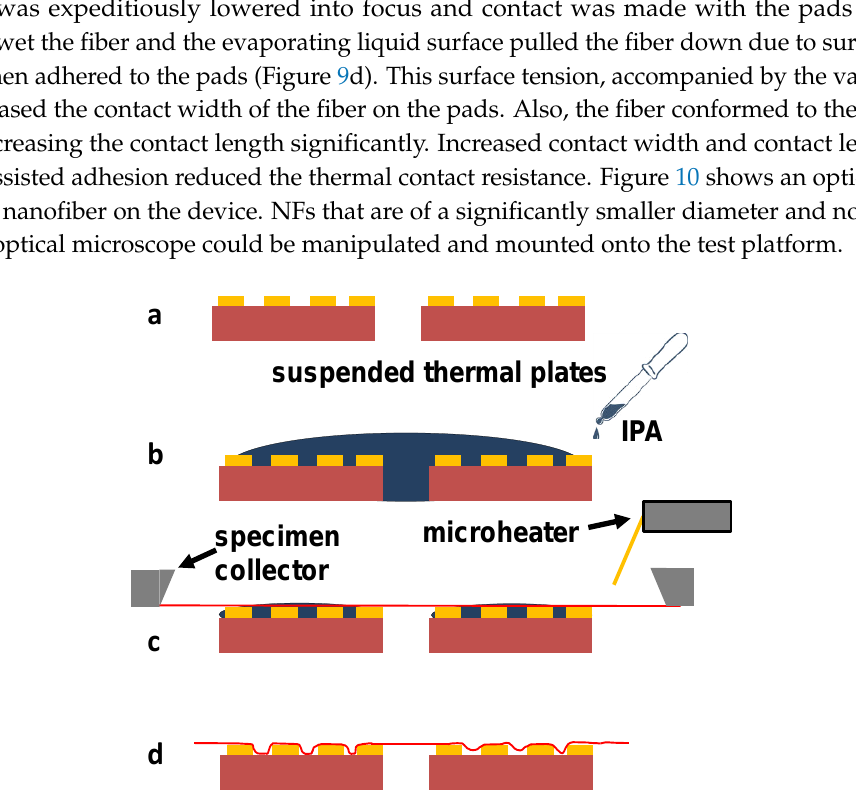
Figure 10. Optical image of a UHWMPE nanofiber sample mounted on the thermal device. 3. Results and Discussion 3.1. Calibration of Mechanical Test Platform Using Silica Fibers Silica nanofibers were used to validate the nanomechanical measurements reported in [3]. They were prepared using a flame brushing technique [34], where a silica microwire was heated in the center using a butane torch and pulled at other two ends. It was stretched until broken; nanofibers were then obtained. The nanofiber was placed on a PDMS substrate, and in this case, conventional manipulation methods were used to mount the fiber. A tungsten tip with a tip of 1 µm diameter connected to a high precision micro-manipulator was used to manipulate the silica nanofiber sample